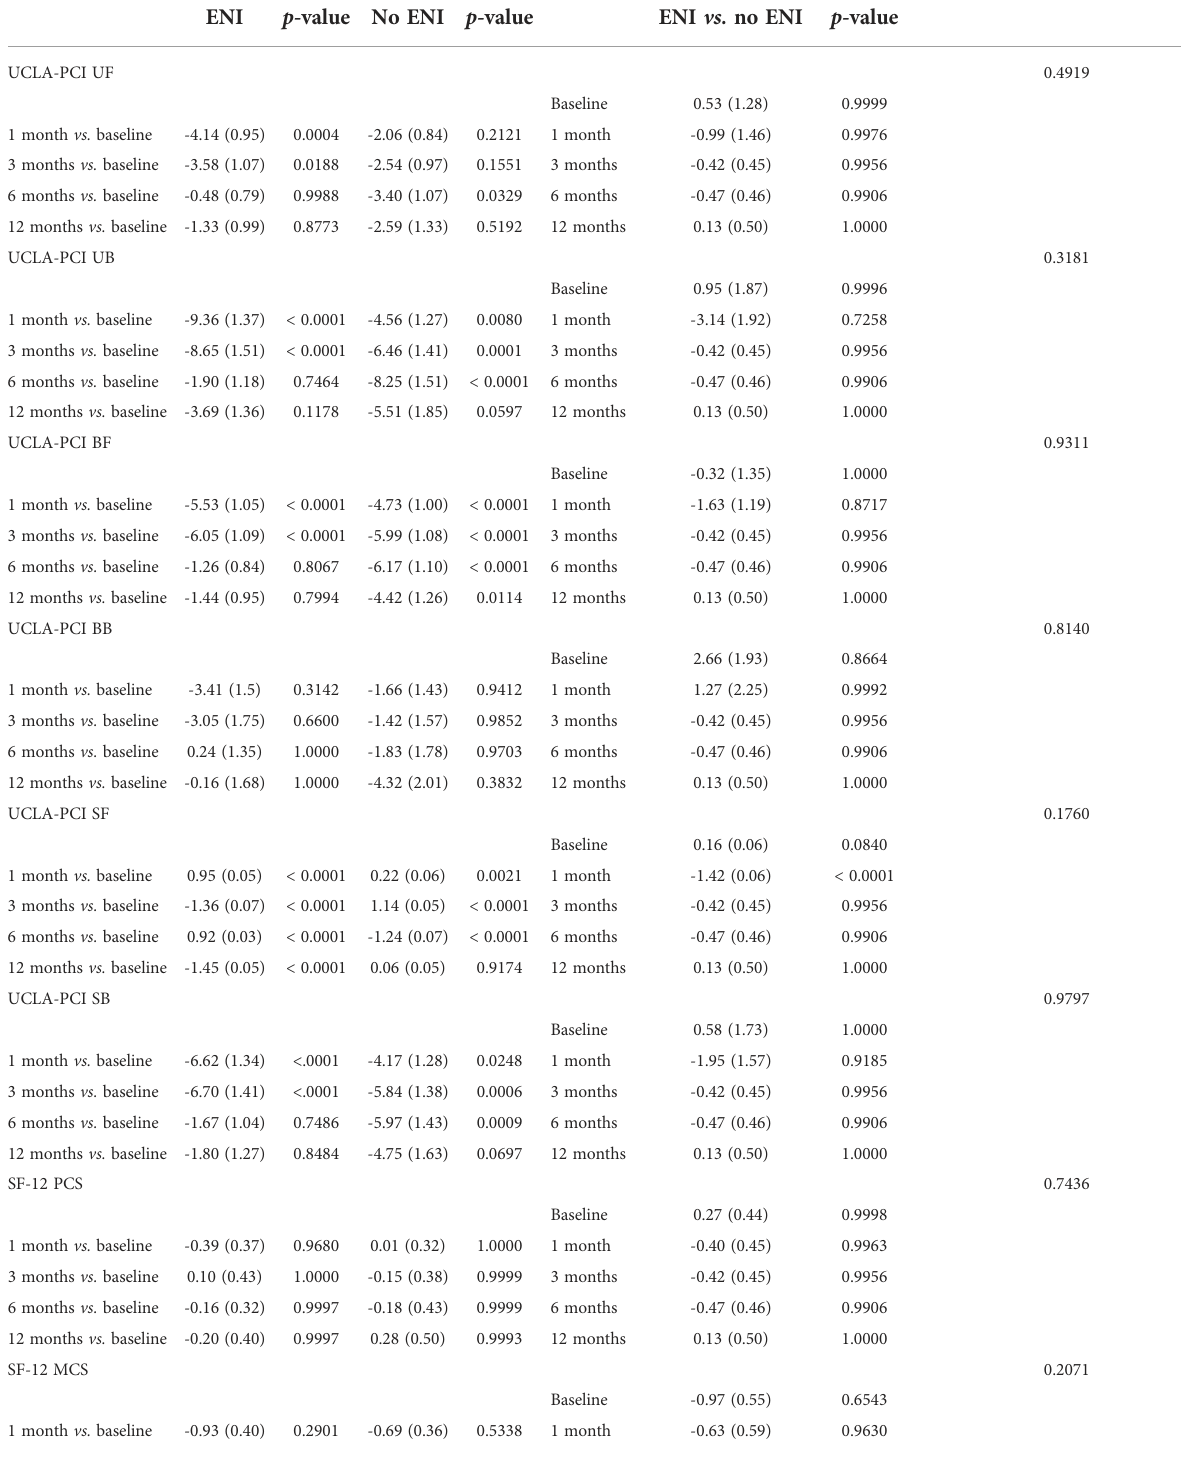
TABLE 4 Comparison of variation of UCLA-PCI and SF-12 scores over time, for ENI versus no ENI groups (numbers indicate estimated mean difference and 95%